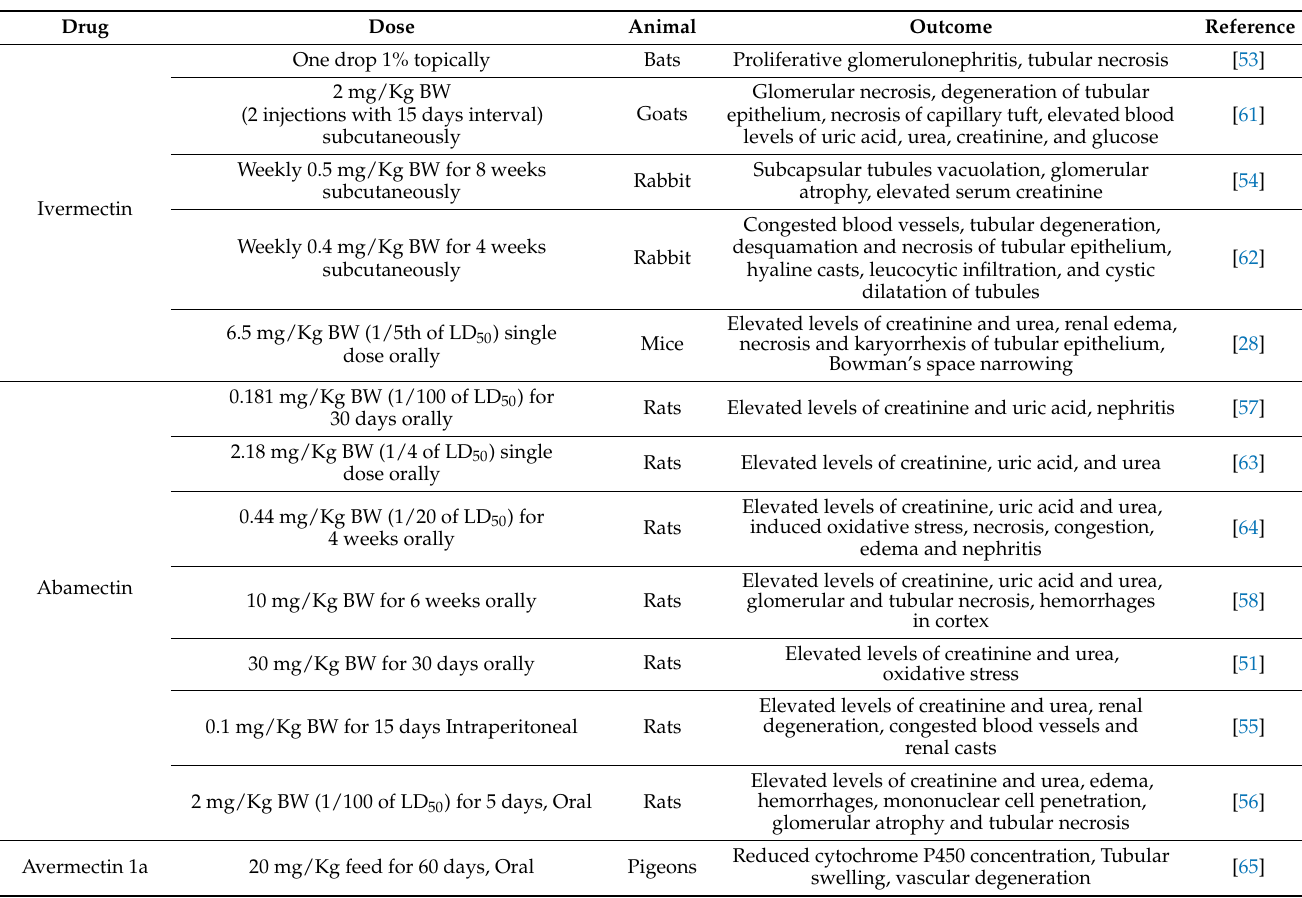
Table 1. Nephrotoxic avermectins along with dose, animal, and